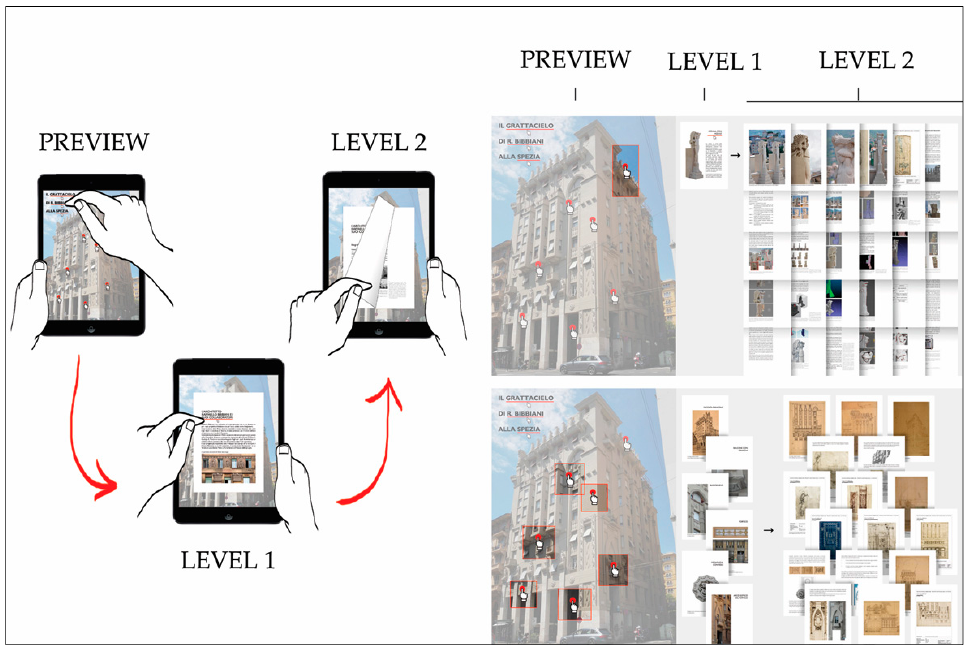
Figure 11. The different levels of detail contained in the app allow filtering the information as user